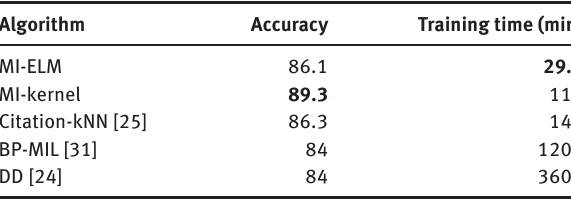
Table 4: Accuracy and Training Time on MUSK2.